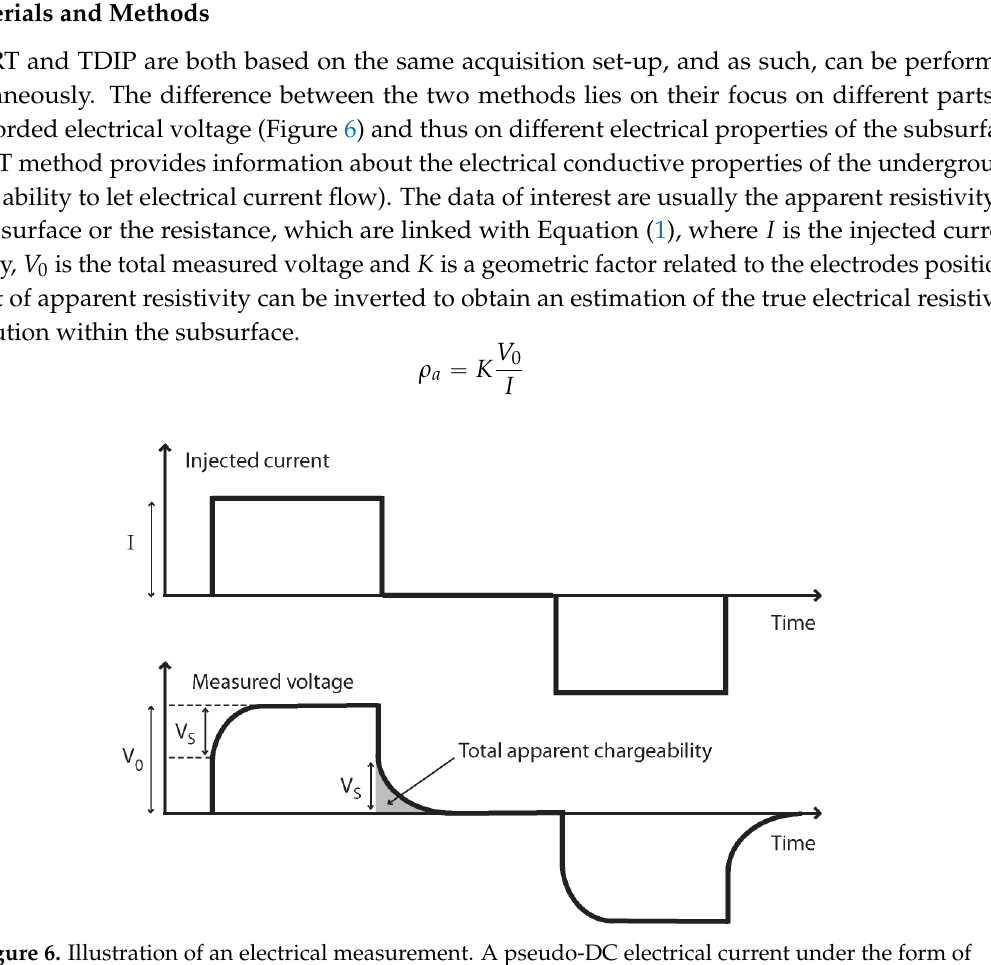
Figure 6. Illustration of an electrical measurement. A pseudo-DC electrical current under the form of square signals with alternate polarities (for error estimation) is injected, producing a voltage signal. The maximum voltage amplitude V 0 is used to compute the apparent resistivity and the decaying secondary voltage V S is used to compute the apparent chargeability (modified after